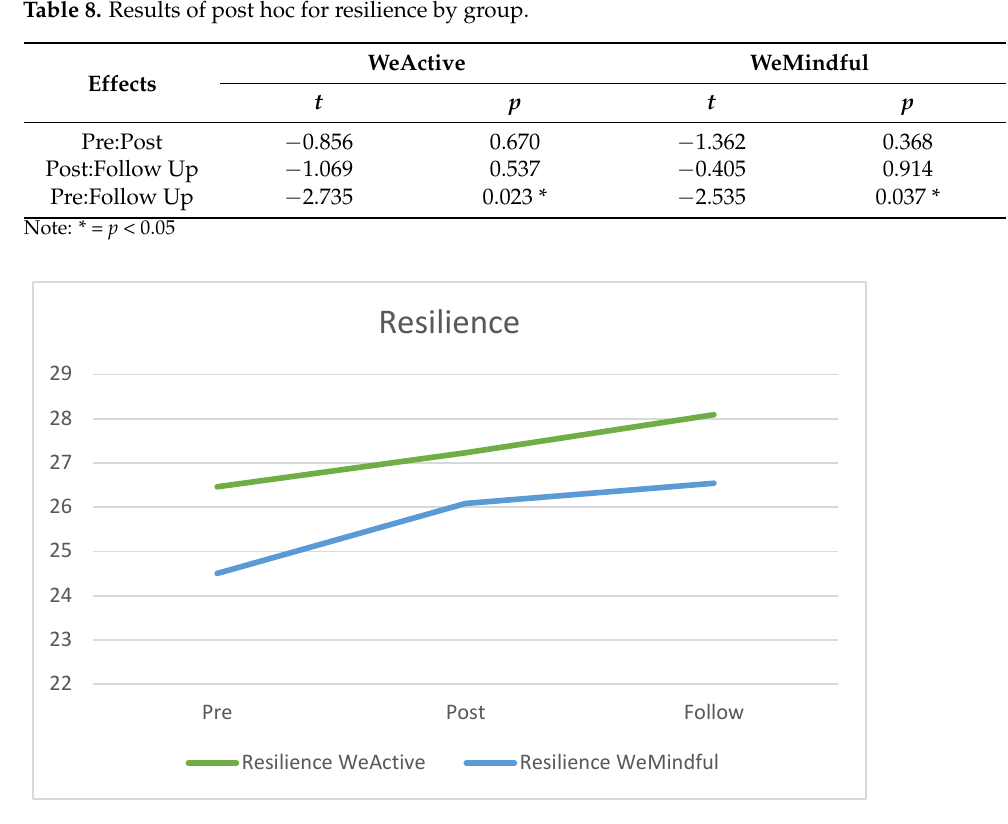
Table 7. Results of repeated-measures ANOVA for resilience.